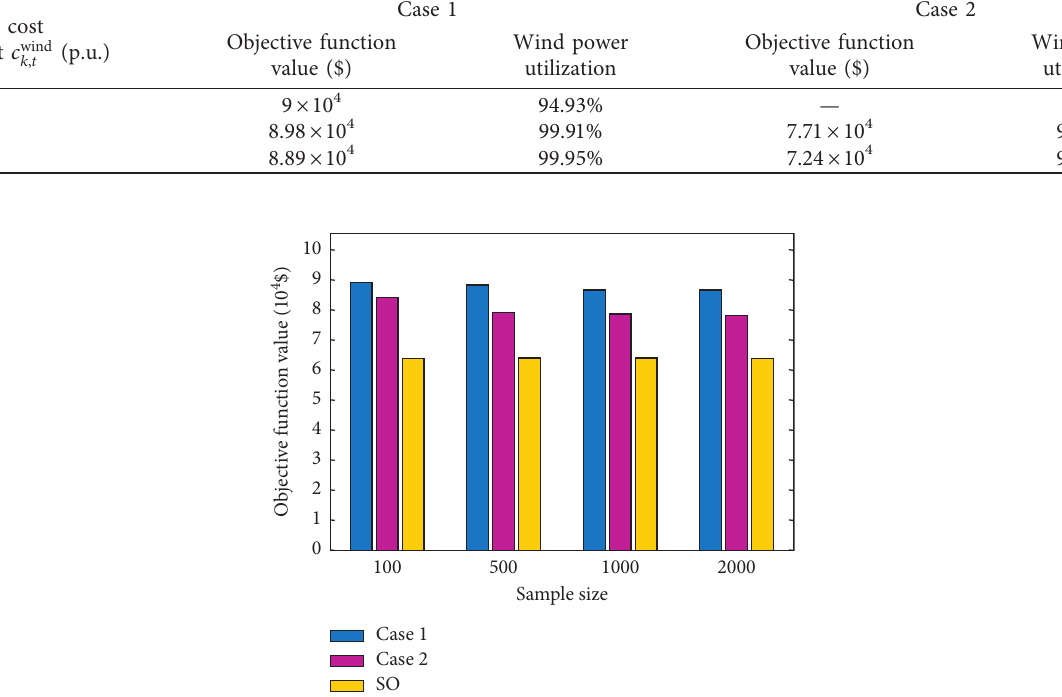
Figure 7: Comparison of objective function value by SO, Case 1, and Case 2 with different historical data.